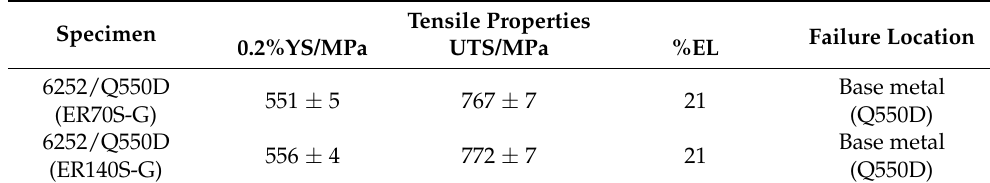
Table 4. Tensile properties of different dissimilar steel welds.